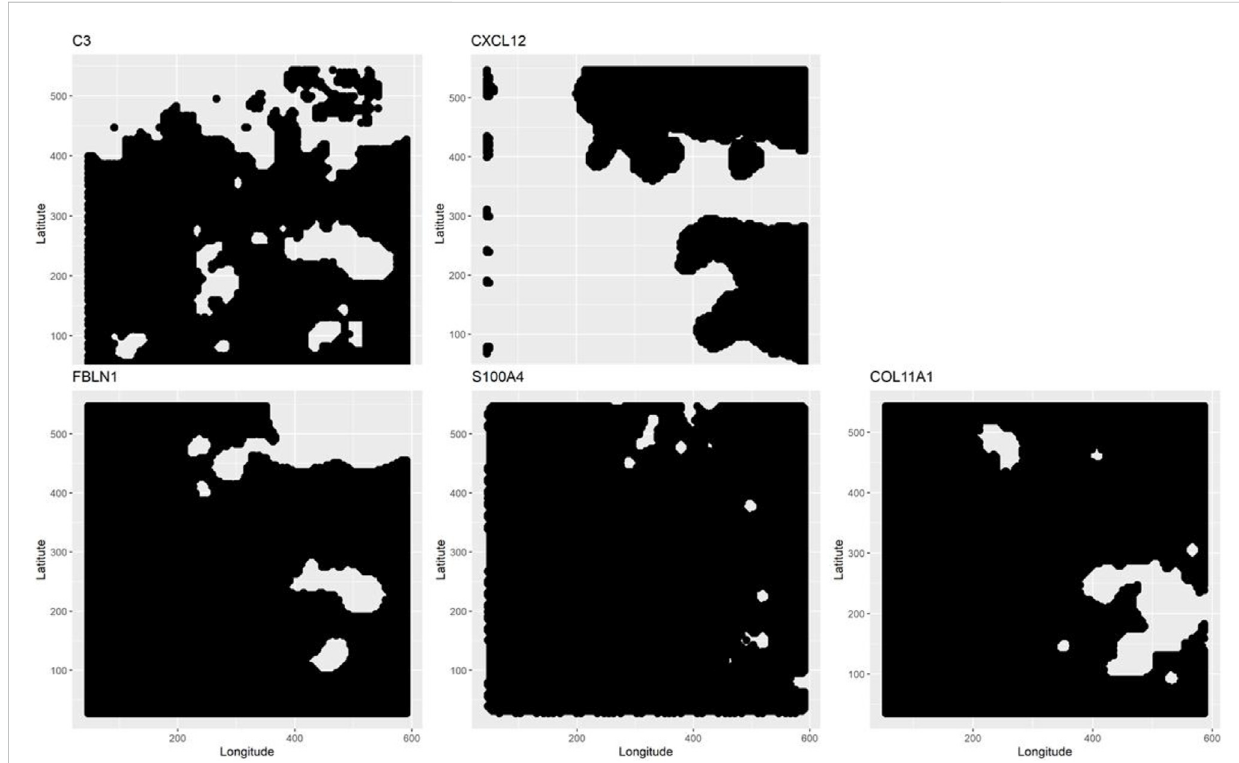
FIGURE 1 Scan statistics are used to detect and demarcate the putative clusters of cells which are enriched with selected gene-sets. The spatial clusters are de fi nedonthetumorspacebyascanstatisticbasedonaPoissondistribution.Atthelocationswherethescanstatisticsexceedapre-speci fi edthreshold, the detected clusters for each phenotype are shown in